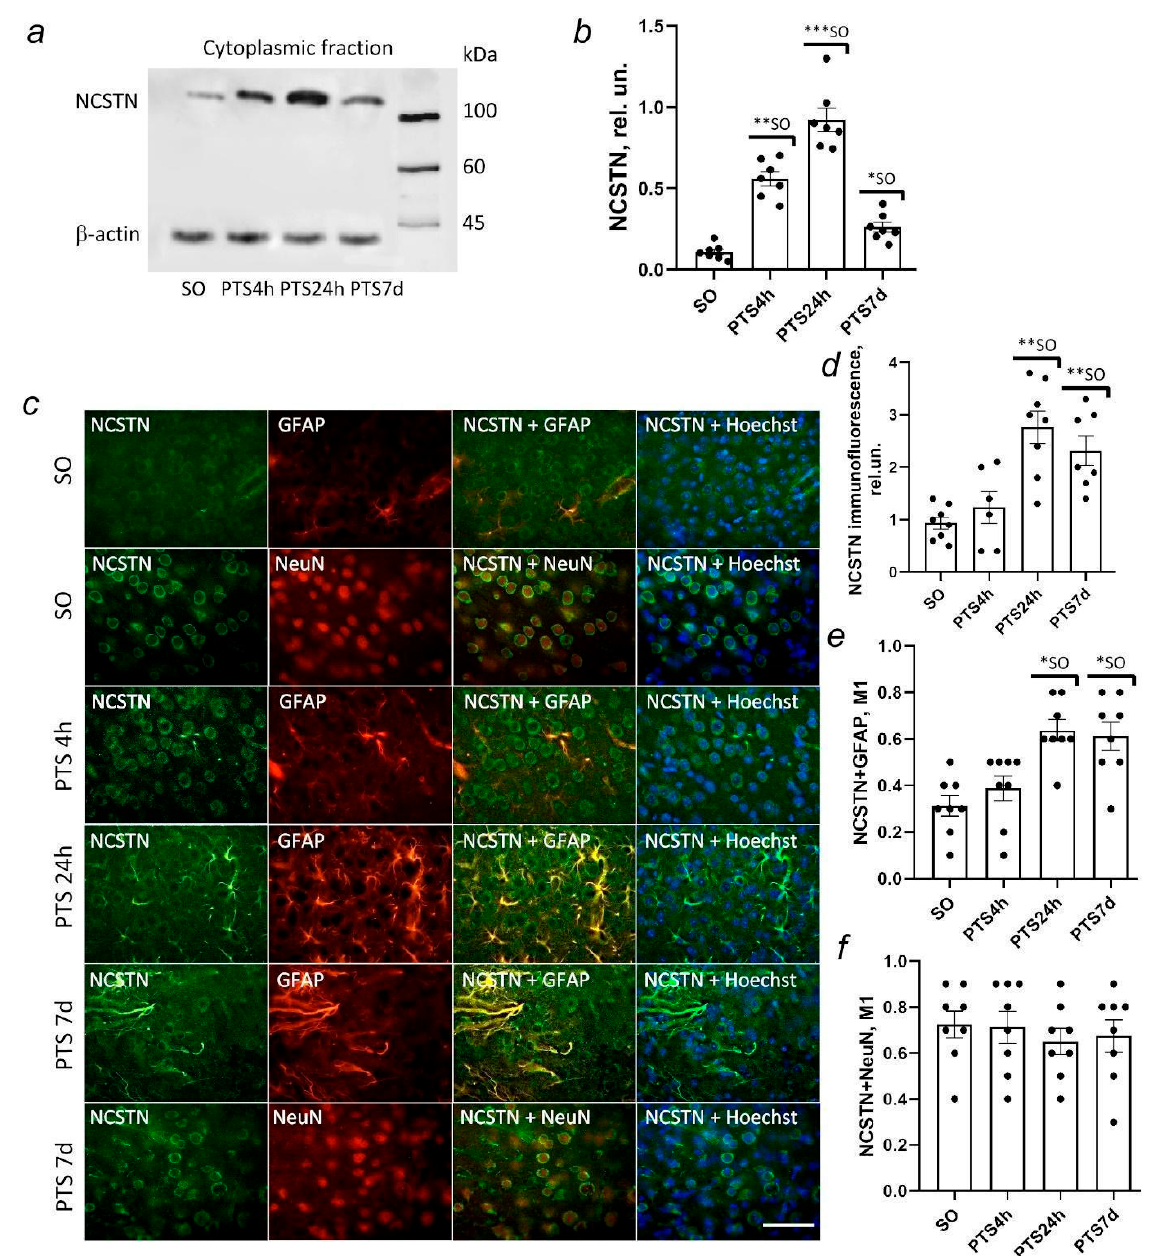
Figure 7. ( a ) Immunoblotting of nicastrin (NCSTN) in the cytoplasmic fraction of the cortex of sham- operated animals (SO) and at 4 h (PTS 4 h), 24 h (PTS 24 h), and 7 days (PTS 7d) after PTS; ( b ) Nicastrin level in relative units at different timepoints after PTS. The indices of the groups of sham-operated animals at 4 h, 24 h, and 7 days after PTS had no statistically significant differences, therefore the indices of the three groups were combined. ( c ) Immunofluorescence of nicastrin (NCSTN) (green), GFAP (astrocyte marker, red), and Neun (neuron marker, red); image overlay of NCSTN with Neun, GFAP, and Hoechst (nuclei marker, blue). Scale bar 100 µ m. ( d ) Changes (in relative units) of nicastrin fluorescence in penumbra cells after PTS and in the cortex of sham-operated rats. ( e ) Localization of nicastrin in penumbra astrocytes. ( f ) Localization of NCSTN in penumbra neu- rons. One-way ANOVA. М ± SEM. n = 7–8. * р < 0.05 compared to the SO; ** р < 0.01 compared to the SO; *** р < 0.001 compared to the SO.